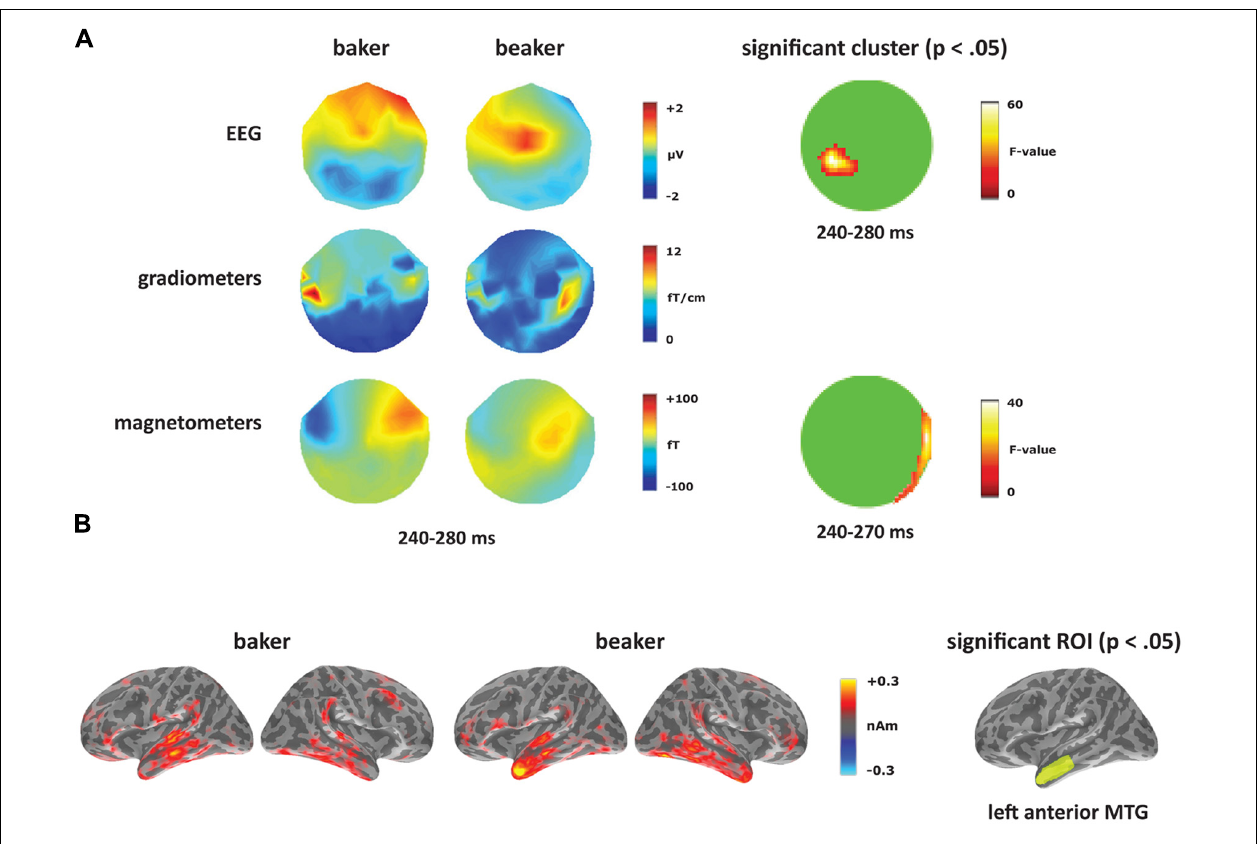
FIGURE 6 | Derivational transparency contrast: baker vs. beaker . (A) Topographies from 240 to 280 ms and significant clusters from sensor-level analyses. (B) Source activation for [-er] word deviants from 240 to 280 ms, and the significant ROI from the source analysis (left anterior